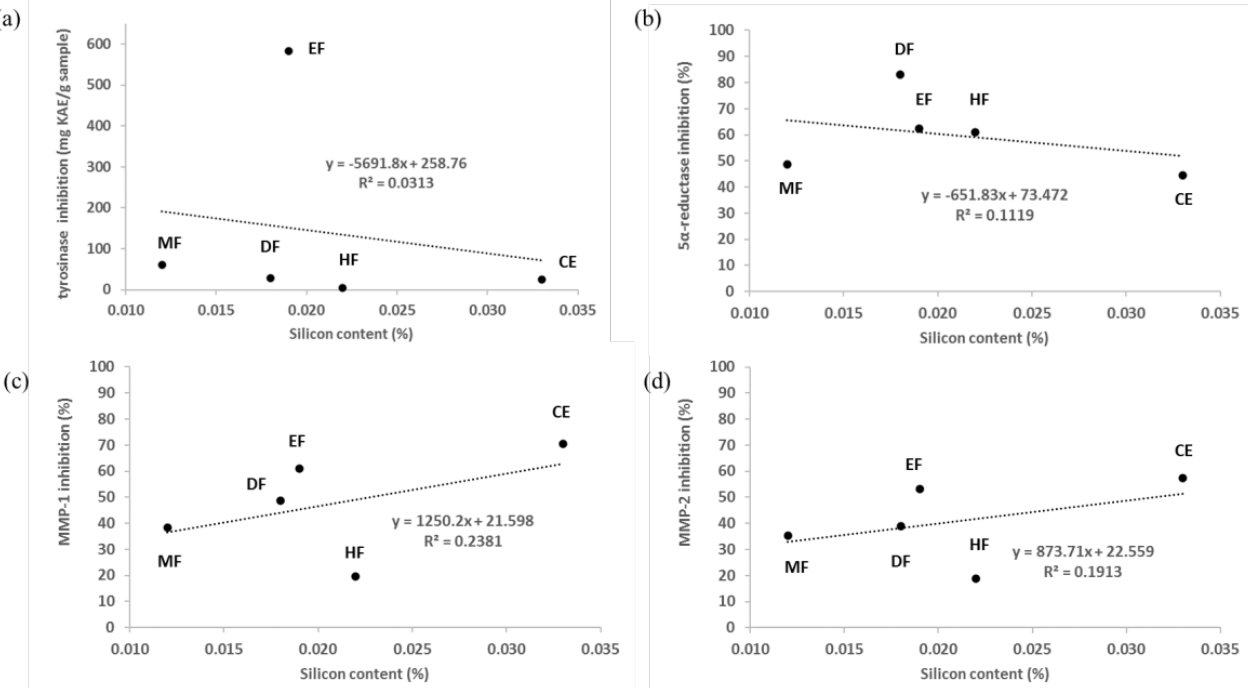
Figure 4. Relative scatter plot of silicon content and inhibition activities of crude extract (CE), hexane fraction (HF), dichloromethane fraction (DF), ethyl acetate fraction (EF), and methanol fraction (MF); ( a ) anti-tyrosinase activity (regression p -value = 0.7758); ( b ) anti-5 α -reductase activity (regression p -value = 0.5821); ( c ) anti MMP-1 activity (regression p -value = 0.4044); and ( d ) anti MMP-2